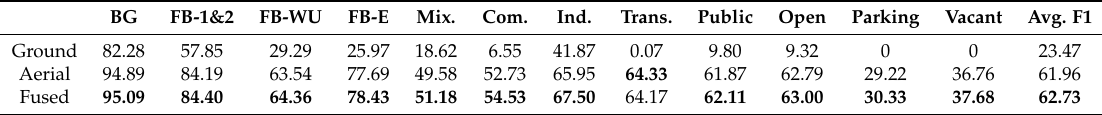
Table 3. Per-class results on Brooklyn validation set